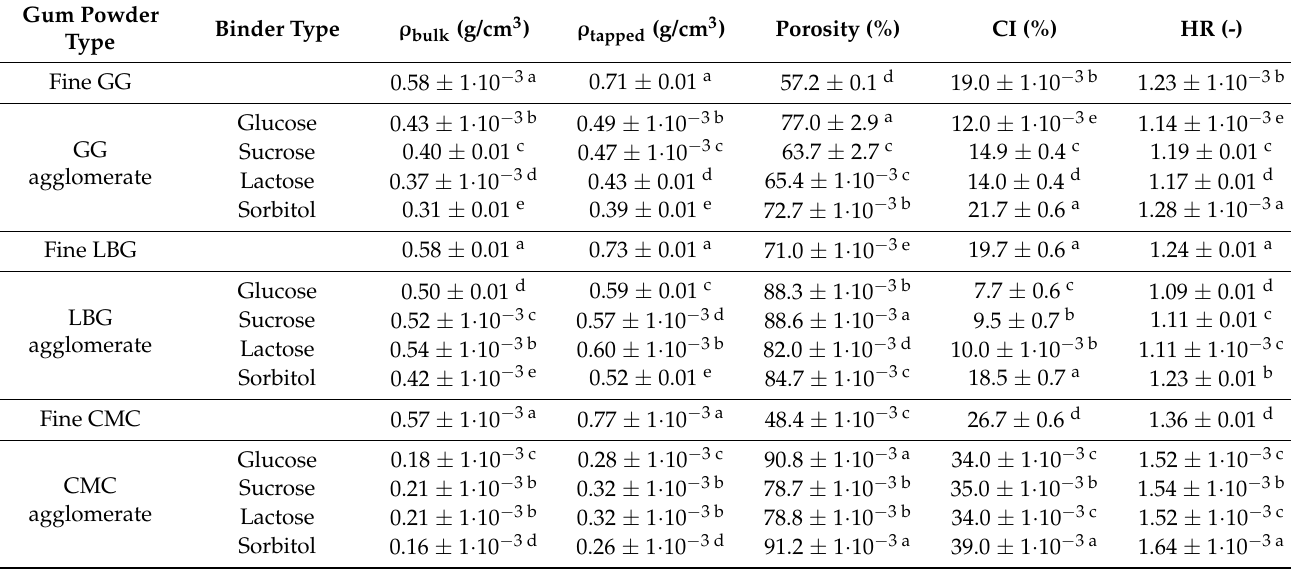
Values are means of triplicate measurements ± SD. Means with different lowercase letters (a–e) within each column are significantly different ( p <